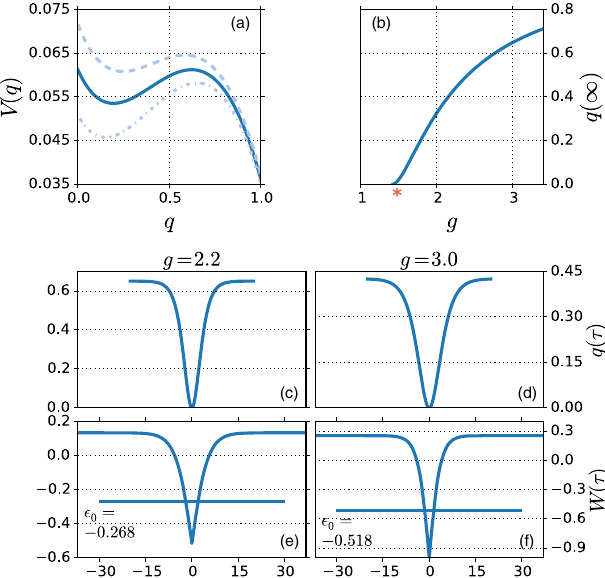
FIG. 3. Calculation of the largest Lyapunov exponent for a threshold-linear network . (a) Numerical integration of Eq. (45). The value of x is determined through the requirement that the maximum of the potential at nonzero q equals its value at zero q . Compare the form of the potential with the exact value of x (solid line) with those calculated with x deviating by (cid:3) 1% from the correct value (dashed lines). (b) Numerical solution for the normalized variance q ð ∞ Þ as a function of g . (c) – (f) The normalized autocorrelation function q ð τ Þ found by integrating the equation of motions (45) using the correct value of x for two values of g (top), and the corresponding quantum potential W ¼ −∂ 2 V= ∂ q 2 (bottom). The ground-state energies ϵ 0 (hori- zontal lines) were found numerically. In both cases, they are negative, implying a positive Lyapunov exponent.